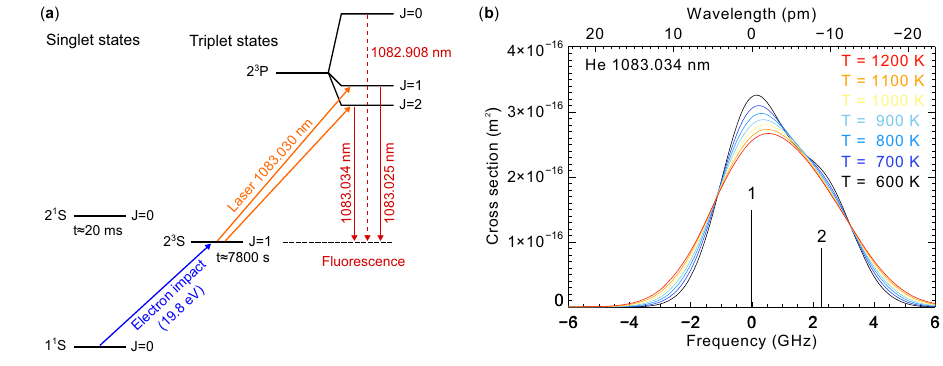
Fig. 1 | He(2 3 S) energy levels and fl uorescence spectrum. a Energy levels and transitions in He that are relevant to the He lidar. b Theoretical Doppler- broadened fl uorescence spectrum of He(2 3 S) at 1083nm wavelength for a range together at thermospheric temperatures; this combined line is the target of this paper.